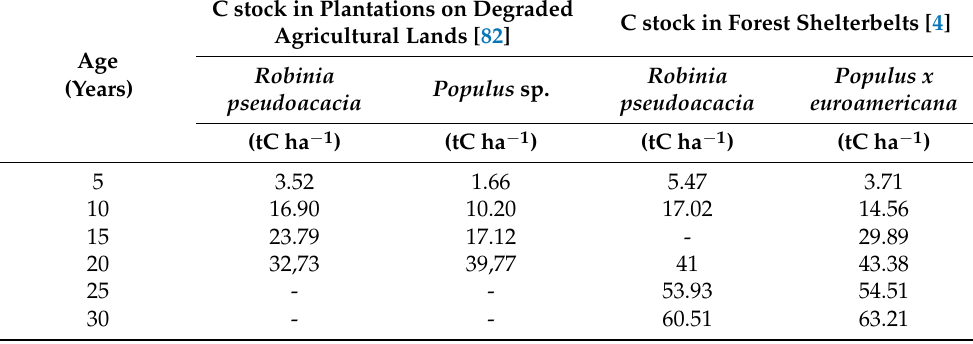
Table 3. Carbon (tC ha − 1 ) stock in woody living biomass in plantations/shelterbelts for black locust and poplar